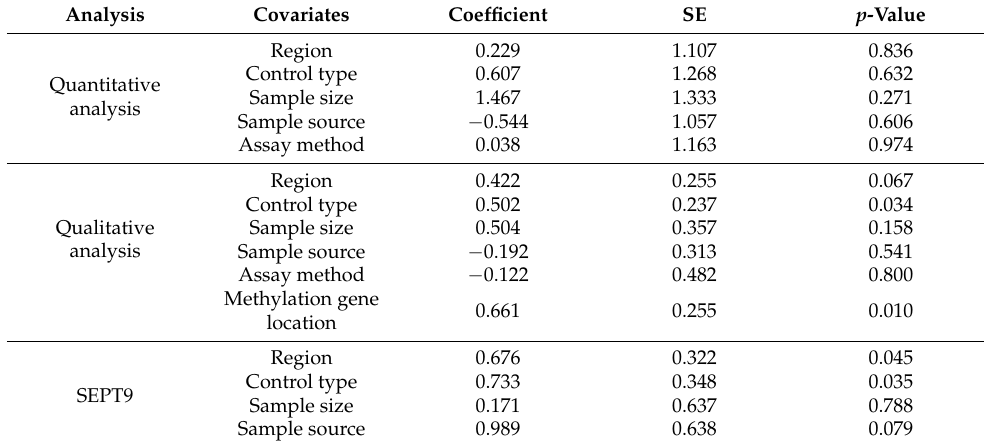
Table 3. Meta-regression of impacts of study features on diagnostic value of ctDNA for